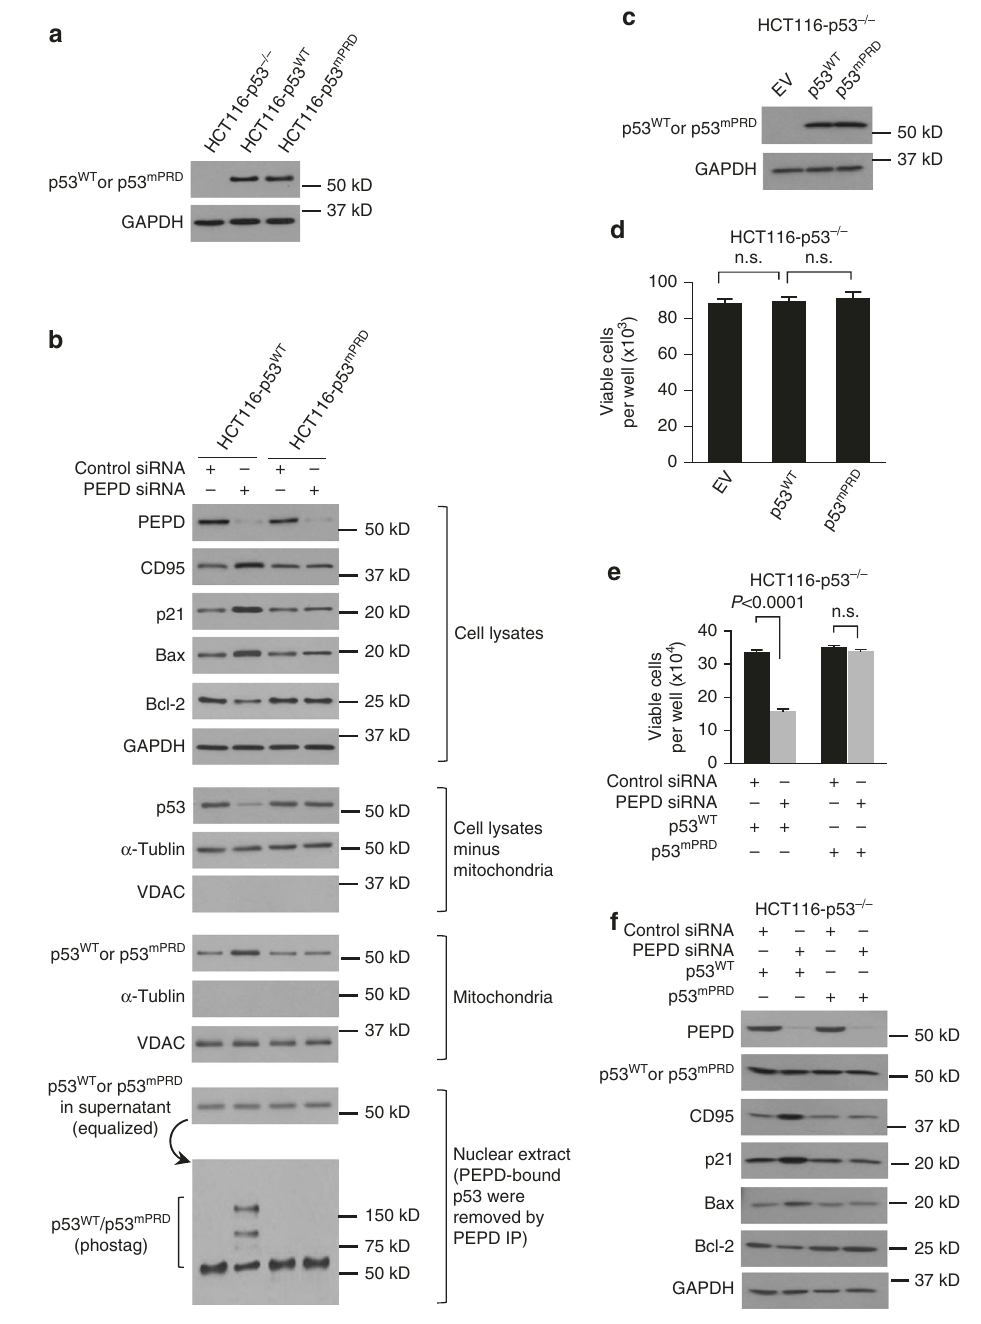
Fig. 6 PRD mutation inactivates p53. a IB analysis of p53 WT and p53 mPRD . b IB analysis of various proteins in whole lysates and subcellular fractions of cells treated with control siRNA or PEPD siRNA for 48 h. c , d IB analysis of p53 WT and p53 mPRD , as well as analysis of cell viability at 48 h after plasmid transfection. Cells were cultured in 24-well plates (5 × 10 3 cells/well) for 24 h before plasmid transfection. e , f Analysis of cell viability and IB analysis of various proteins in cells treated with siRNA for 48 h and then transfected with the plasmid for 48 h. GAPDH, α -tubulin and VDAC were measured to ensure the purity of the subcellular fractions or as loading controls. Cells were cultured in 6-well plates (8 × 10 3 cells/well) for 24 h before experimental treatment. Data are means ± s.d. ( n = 3); one-way ANOVA followed by Tukey multiple comparisons test in d ; two-way ANOVA followed by Tukey multiple comparisons test in e ; n.s., not signi fi cant cellular p53 molecules that bind to PEPD, all PEPD molecules in dehydrogenase (GAPDH) level in all samples (Supplementary cell lysates were pulled down with a PEPD antibody in excess, and Fig. 8b) to con fi rm the validity of the approach. We found that ~ the percentage of p53 molecules that remained in the supernatant 51 – 55% of p53 molecules in the cell lines are bound to PEPD was determined by comparing the intensity of the p53 band with (Fig. 5f). Nearly identical result was obtained by calculating the that of the input control (Fig. 5e; Supplementary Fig. 8b). We also percentage of p53 present in the pull-down samples. Thus, compared p53 level in isotype-matched IgG-treated samples and whereas only a small fraction of cellular PEPD binds to p53, more other samples (Fig. 5e) or glyceraldehyde 3-phosphate than half of cellular p53 are bound to PEPD. p53 binds to PEPD NATURE COMMUNICATIONS | 8: 2052 | DOI: 10.1038/s41467-017-02097-9 |